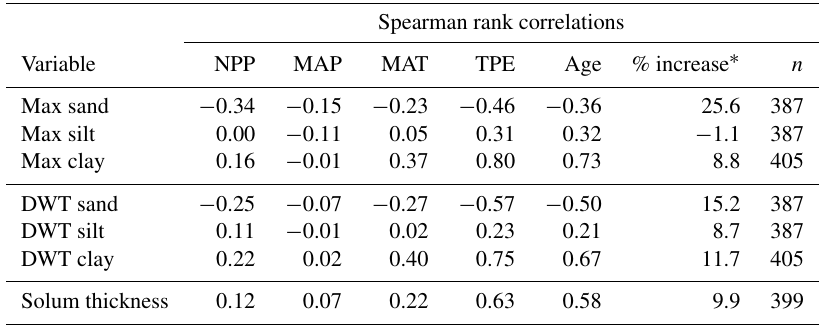
Table 3. Spearman rank correlations between soil physical properties and TPE and age.